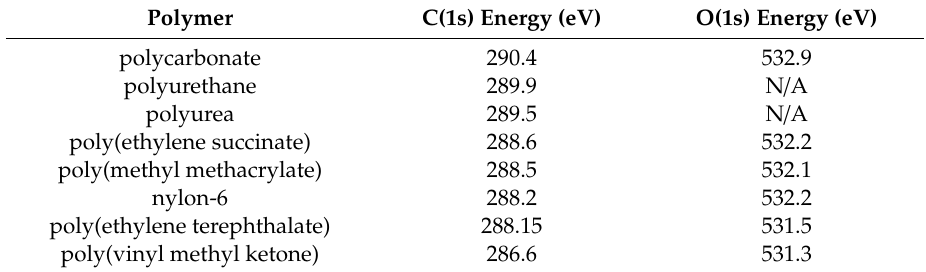
Table 2. NEXAFS energy of 1s → π * C = O transition in carbonyl cores observed from di ff erent polymers.